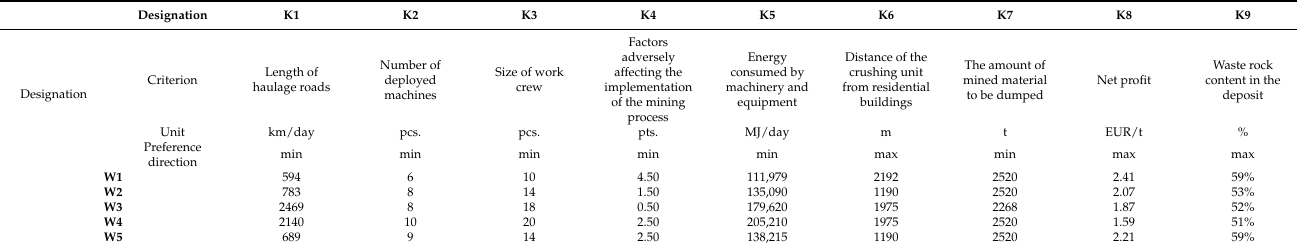
Table 2. Decision matrix of the criteria in the decision variants